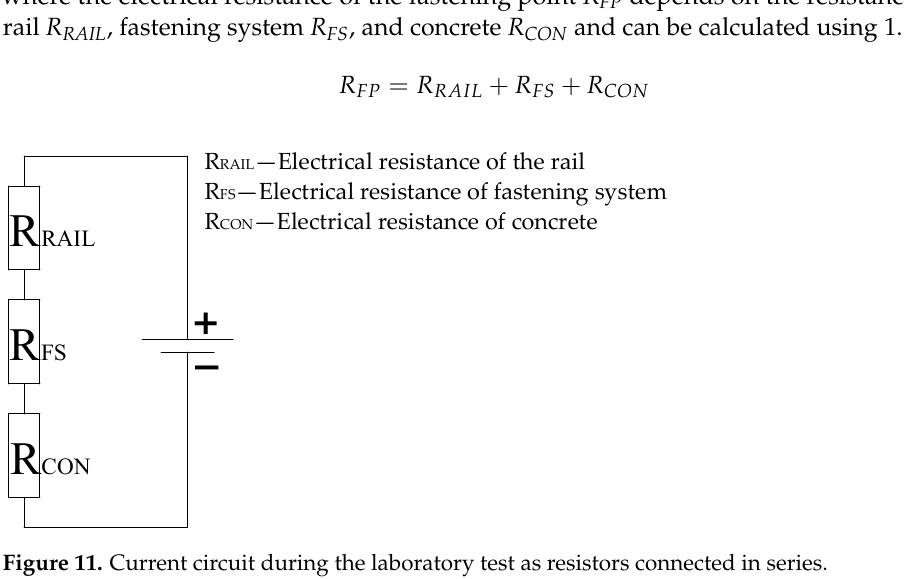
Figure 10. Current circuit during the test.